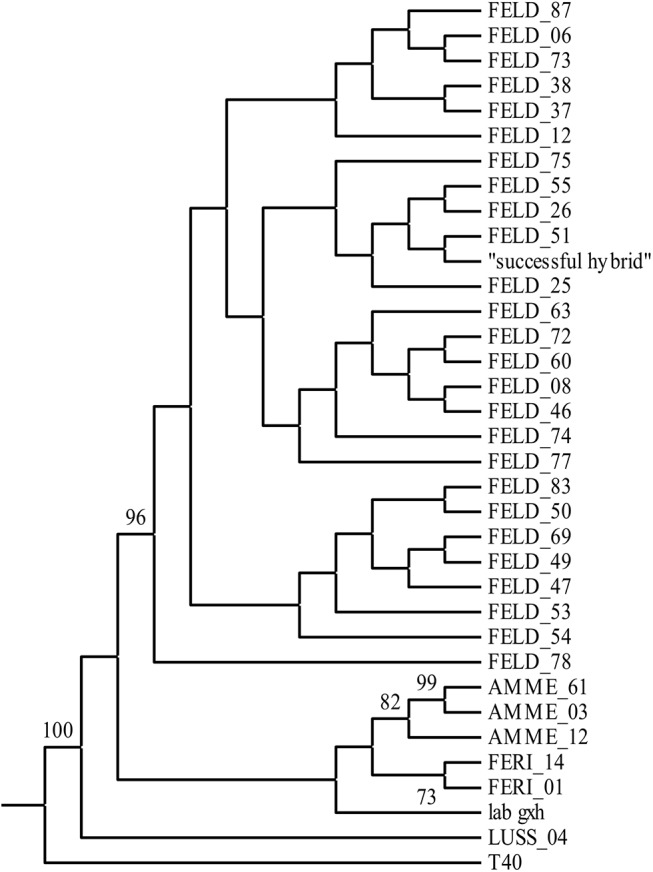
UPGMA clustering of Nei’s genetic distance based on the microsatellite data of the F1- hybrid individuals sampled from the Feldmochinger See.In addition, F1-hybrids used in the experiments (originating from three different lakes: Ammersee, Lußsee, Feringasee; see Table 1) and two reference F1-hybrids (T40 and lab g×h [29]) are included in the tree. The “successful hybrid” clusters with other F1-hybrids from the Feldmochinger See. Only bootstrap values > 50% are shown.